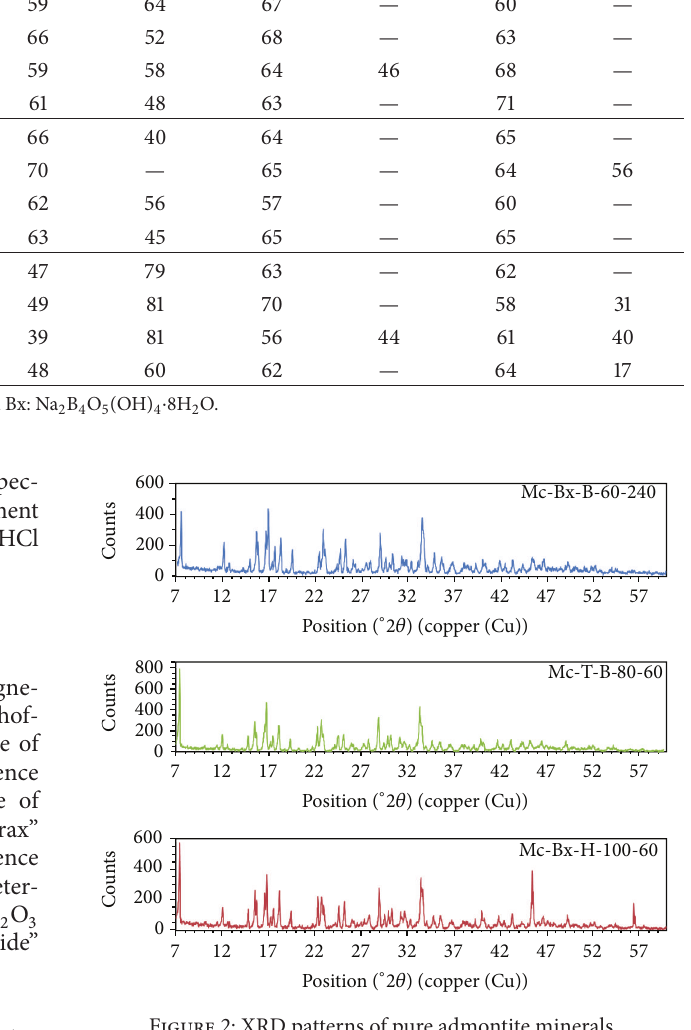
Figure 2: XRD patterns of pure admontite